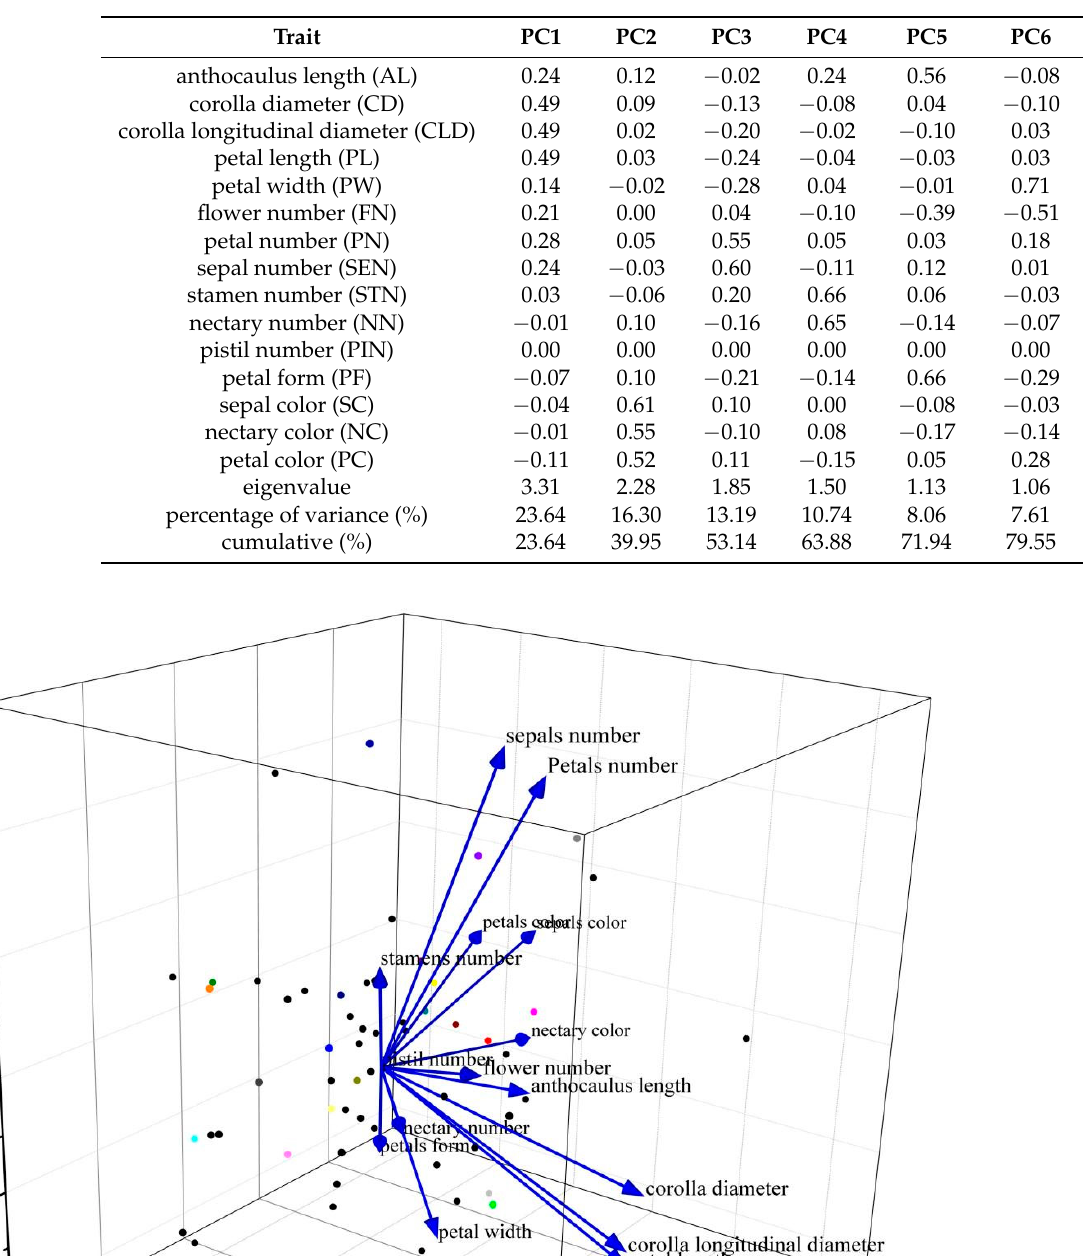
Table 4. Principal component analysis of phenotypic traits of L. chinense var. rubrum .